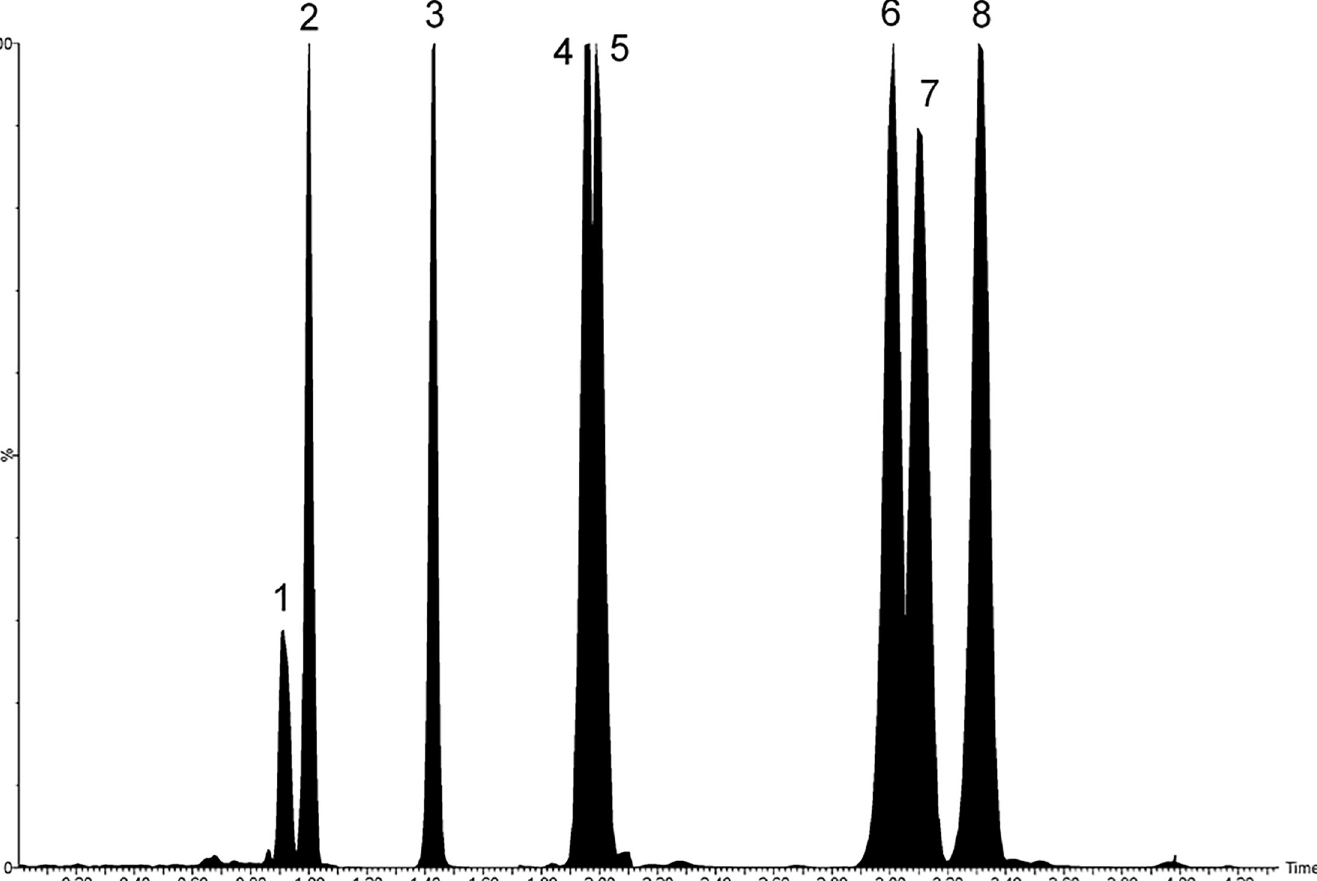
Fig 2. Chromatographic separation of MCPG, HGA, MCPA-carnitine and MCPA-glycine as well as MCPF-carnitine and MCPF-glycine in the serum of an AM horse.